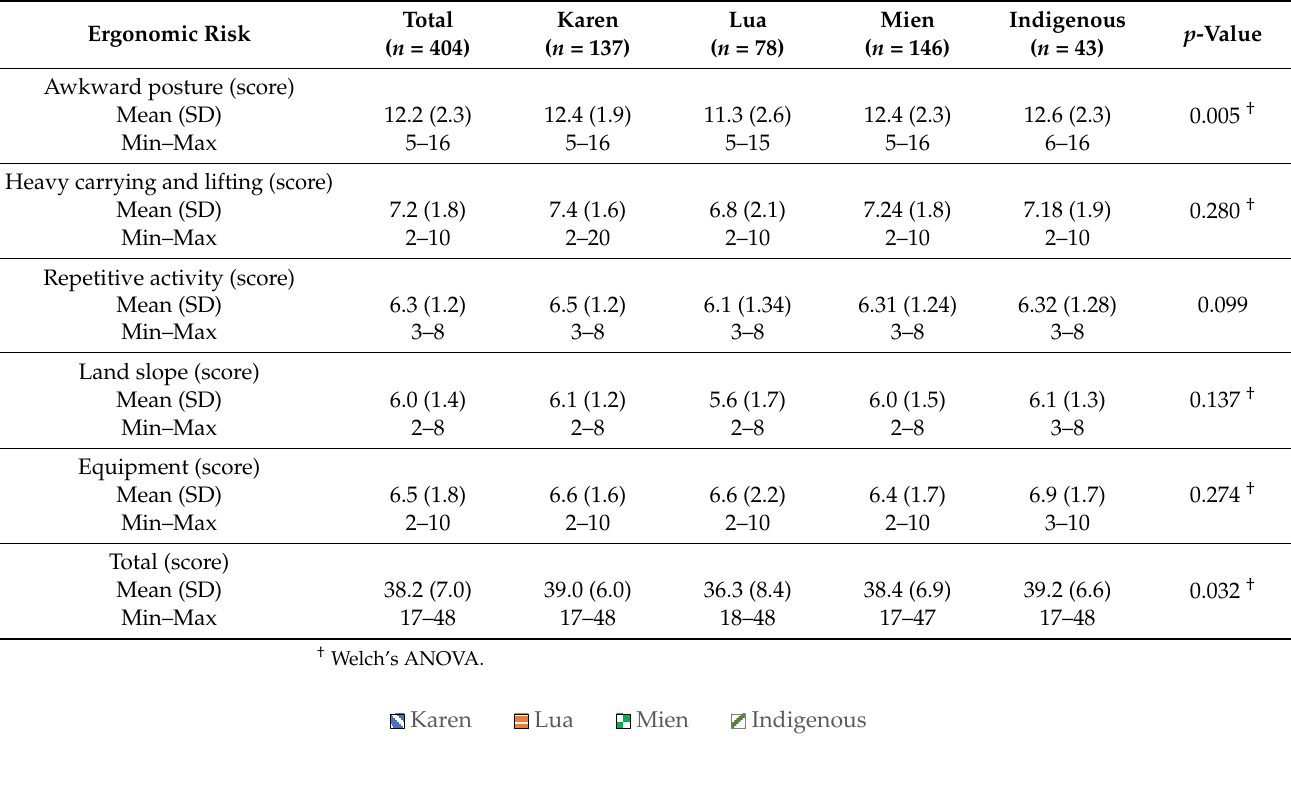
Table 2. Comparison of ergonomic risk scores among ethnic worker groups.